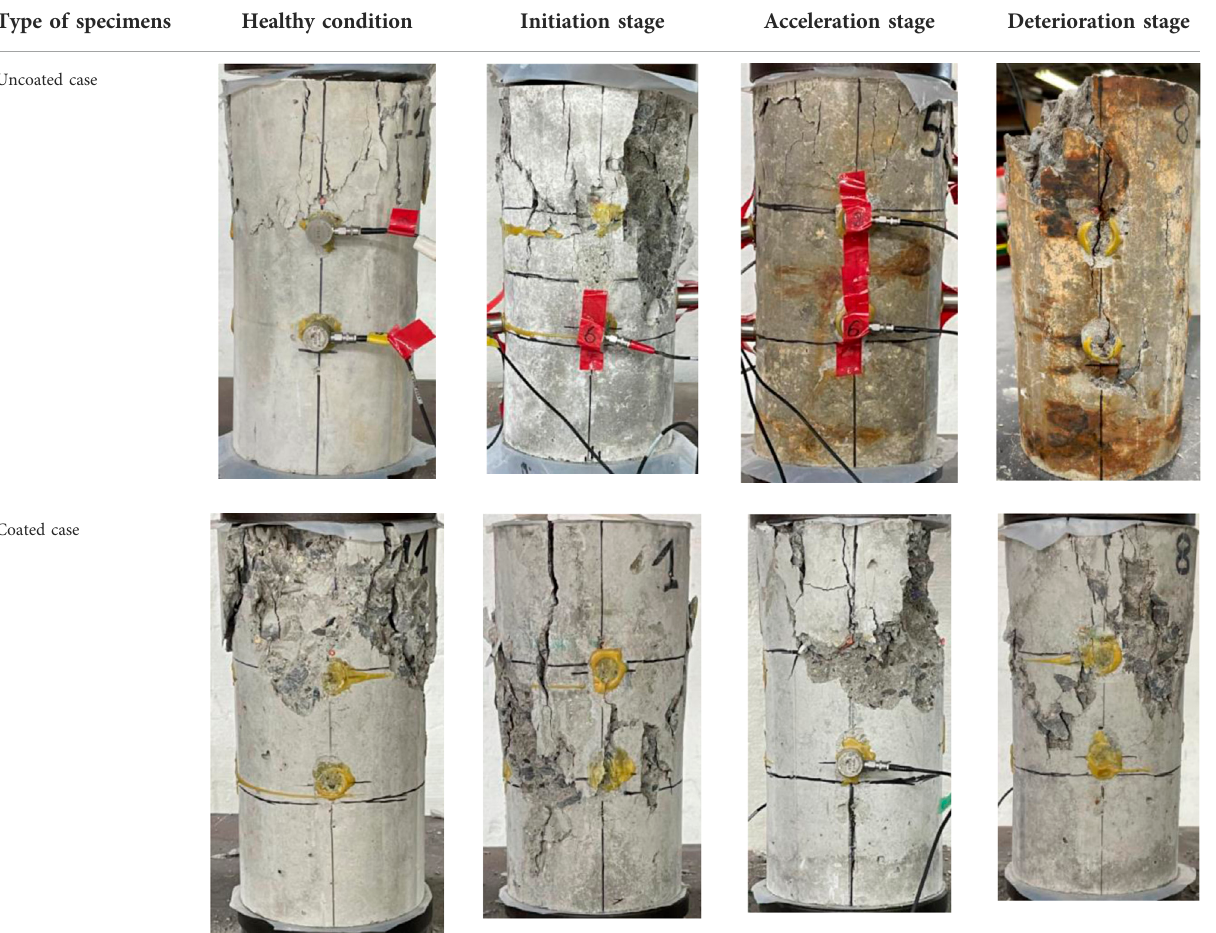
TABLE 5 Conditions after compression